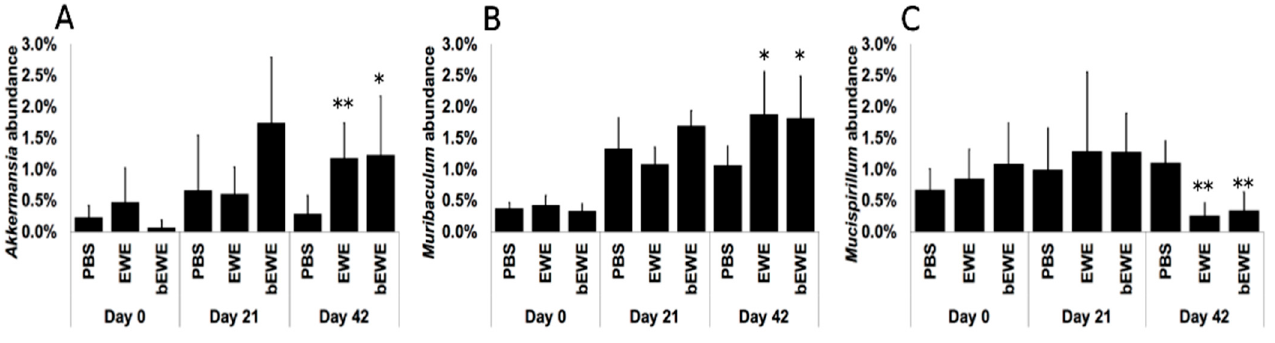
Figure 4. Relative abundance of bacterial taxa at the genus level in mice treated with Euglena water extracts at Day 21 (before LLC cell inoculation) and Day 42 (after LLC cell inoculation). Percentage of taxa abundance of ( A ) Akkermansia , ( B ) Muribaculum , and ( C ) Mucispirillum between PBS and EWE or bEWE were compared at Day 21 and Day 42 using t -test. Results are presented as mean ± SD ( n = 5–6). *: p < 0.05; **: p <